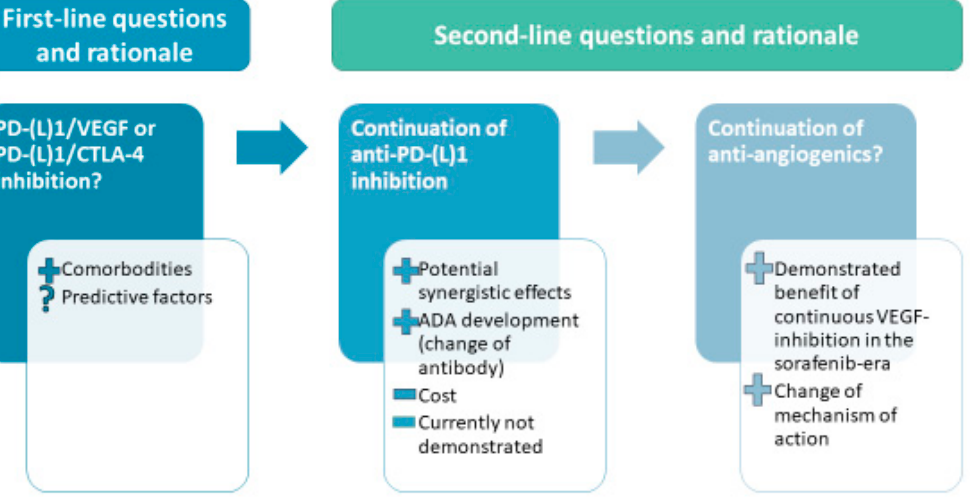
Figure 1. Different questions raised by the possibility of sequences, and rationale behind these questions. ADA: antidrug questions. ADA: antidrug antibodies.